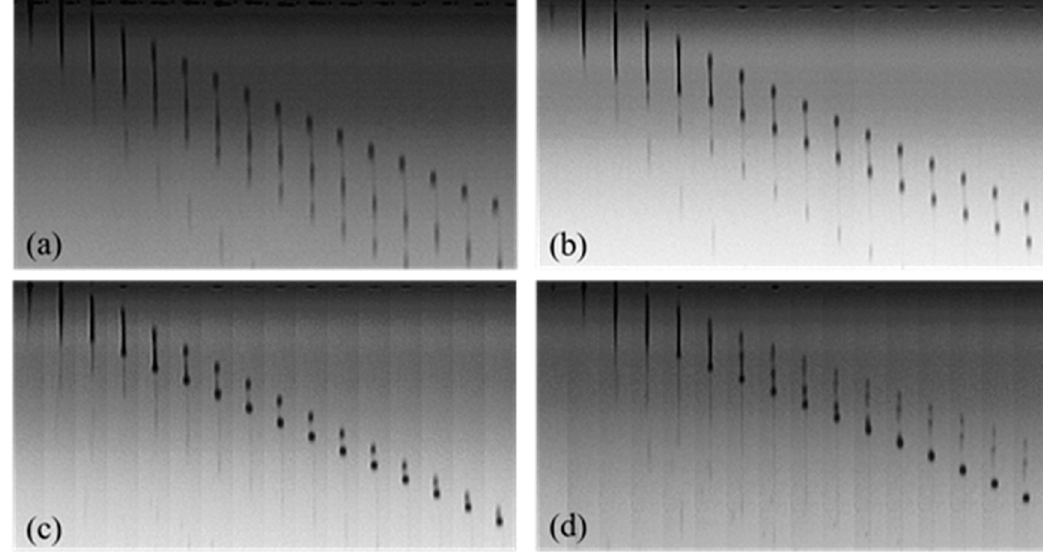
Figure 7. Droplet formation of 7% ( w / w ) Red 218 dye aqueous solutions at different jetting frequency at 25 °C. ( a ) 1500 Hz; ( b ) 5000 Hz; ( c ) 10,000 Hz; ( d ) 20,000 Hz.